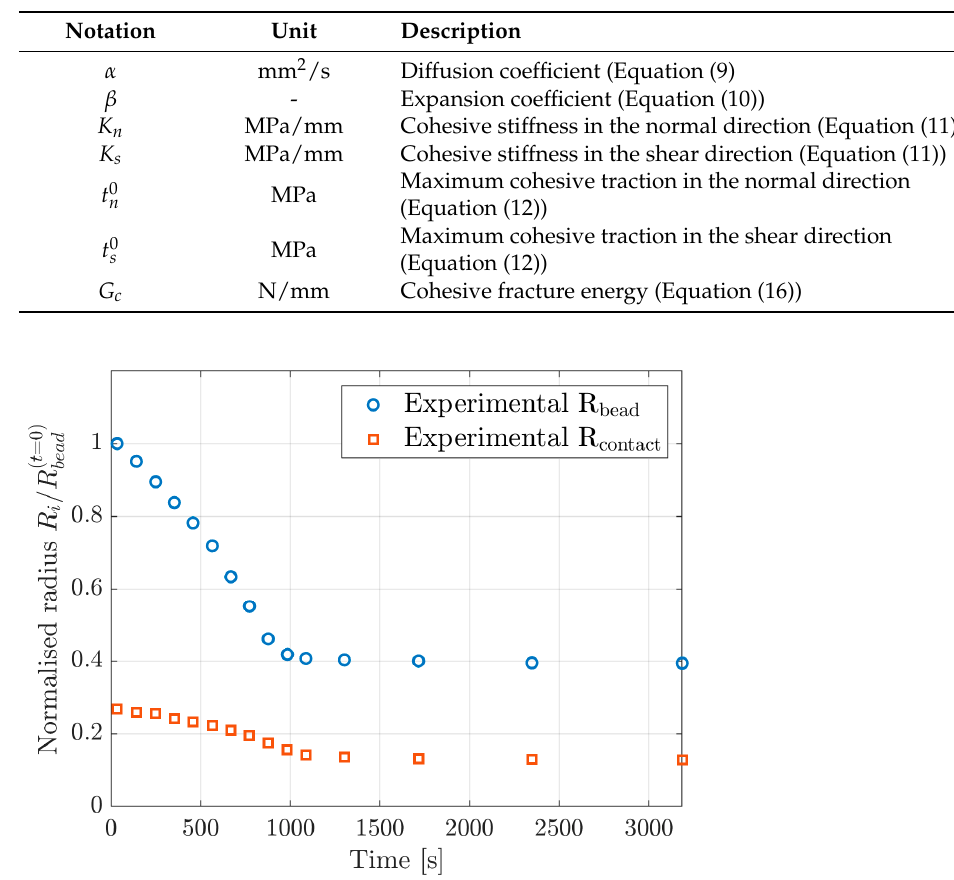
Table 1. Material parameters in the model determined from experimental comparison.